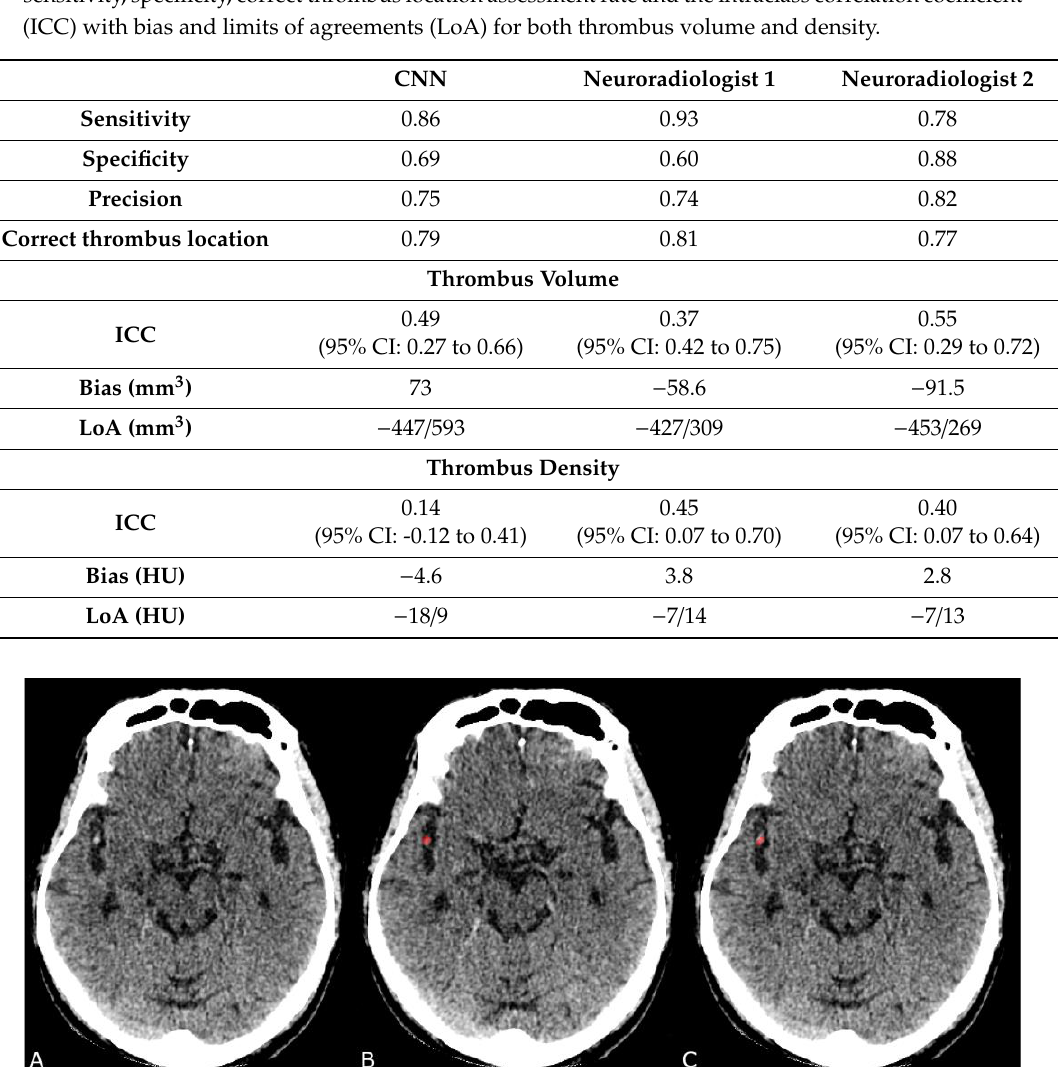
Figure 2. An example of the segmentation results. ( A ) Original non-contrast computed tomography (NCCT); ( B ) Segmentation made by one of the neuroradiologists; ( C ) Segmentation acquired by the